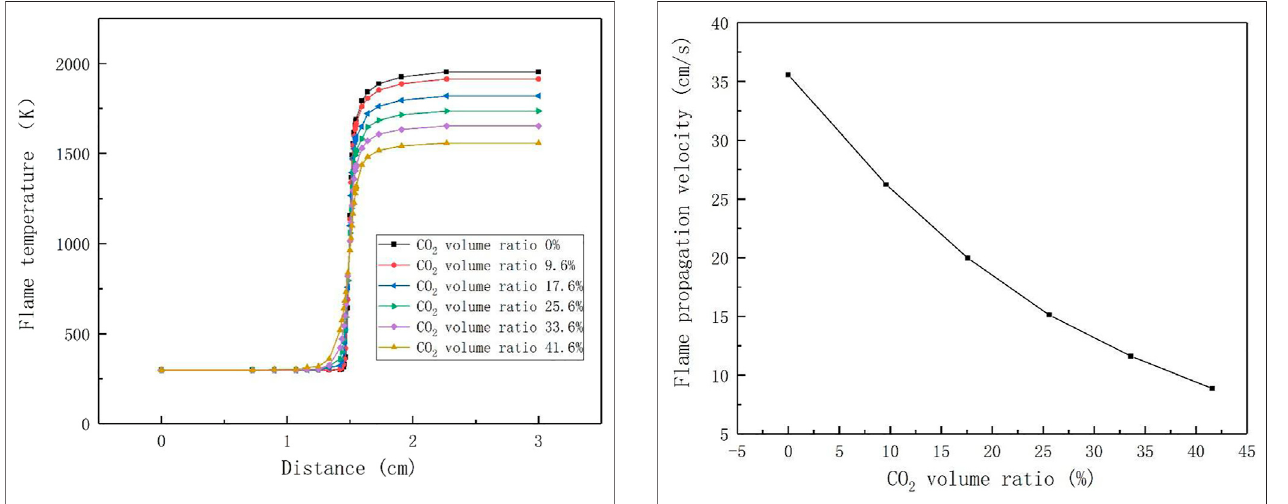
fl ame propagation velocity with CO 2 in chemical